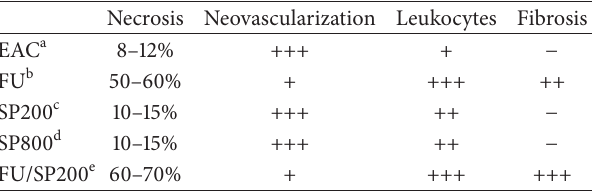
Table3:Histopathologyscoringoftumor-bearingmicetreatedwith 5-fluorouracil (20mg/kg), spirulina (200 or 800mg/kg), and their